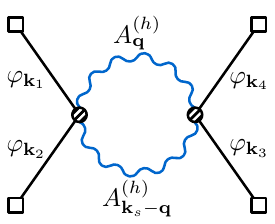
Figure 10 . The 4-point function mediated by a pair of massive vectors A at 1-loop